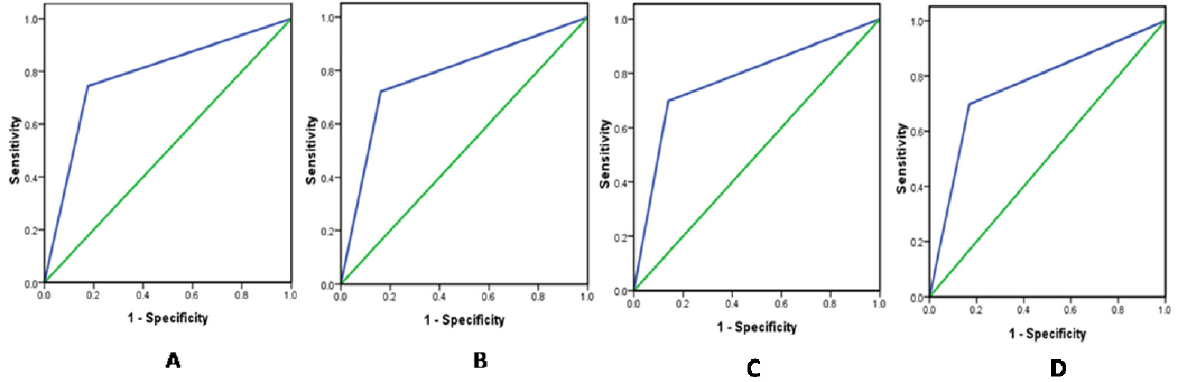
Figure 2. The discriminatory values, according to the area under the curve (AUC) values, for nipple discharge ( A – D ) and serum ( E – H ). ( A ) CA15-3; ( B ) CA125; ( C )